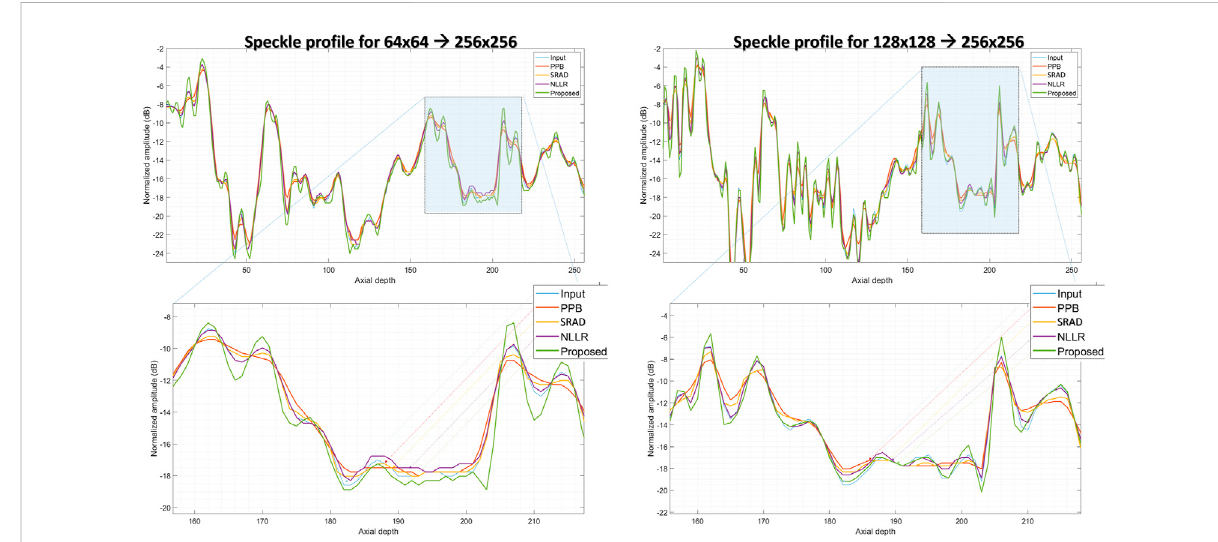
FIGURE 10 Comparison of speckle pro fi le for two resolution settings. (top):speckle pro fi le from the lateral mid-point of in-vivo sample shown in Figure 9, (bottom):zoomed-in view of the highlighted region shown in (top) fi